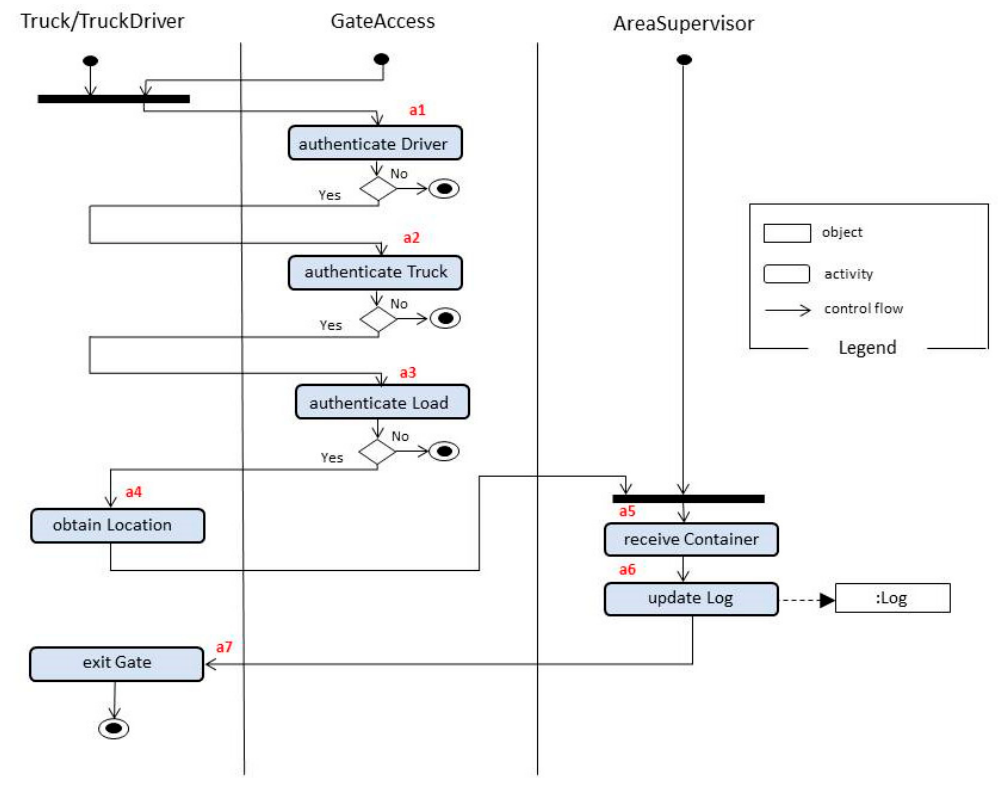
Figure 7. Activity Diagram for use case drop-o ff export container.